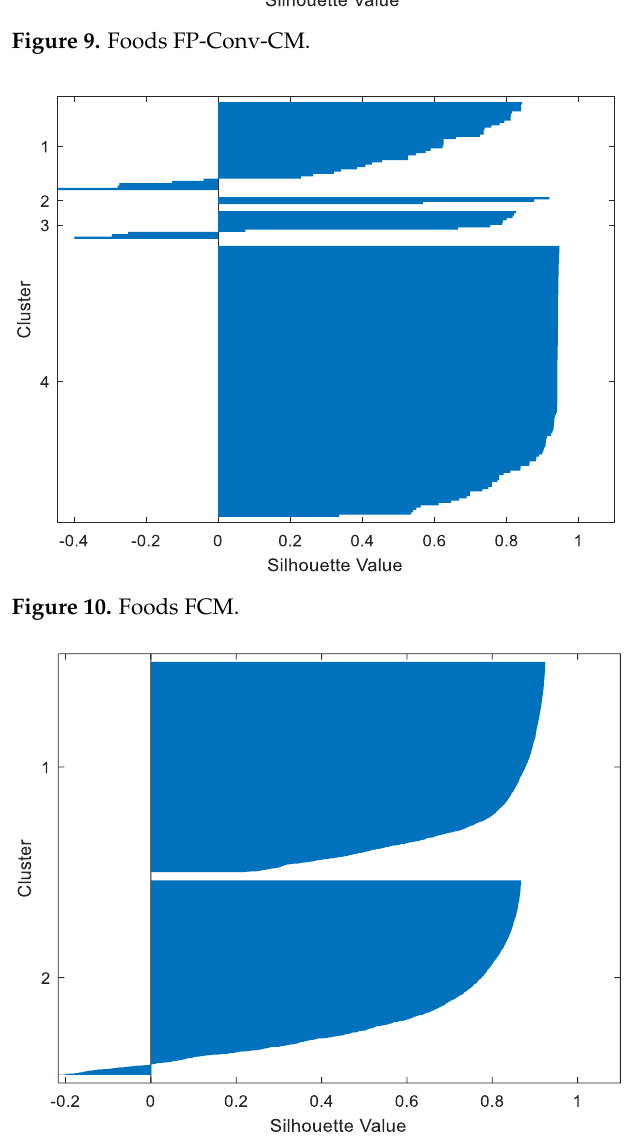
Figure 11. Foods Figure 11. Foods GMM.